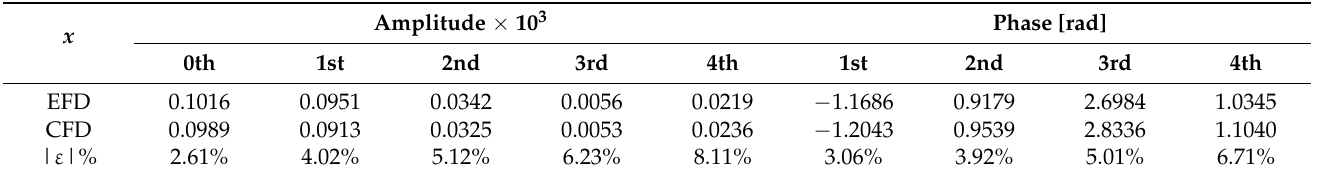
Table 10. Harmonic amplitudes and phases of surge ( x ) for the FRxz ϕθ bow waves scenario.